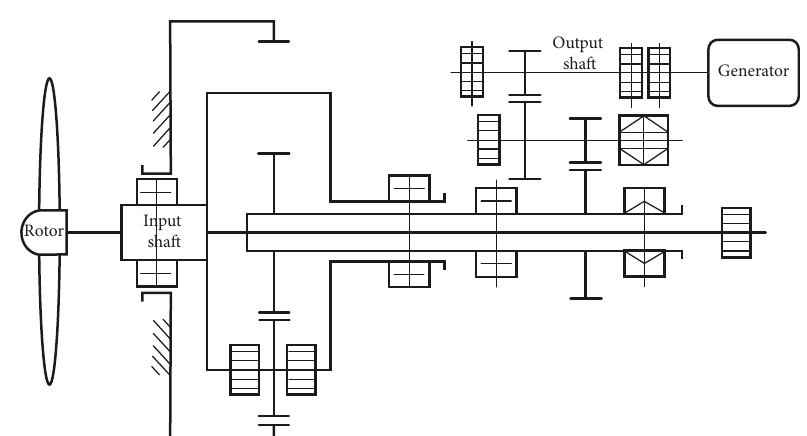
Figure 2: Structure of a wind turbine gearbox.